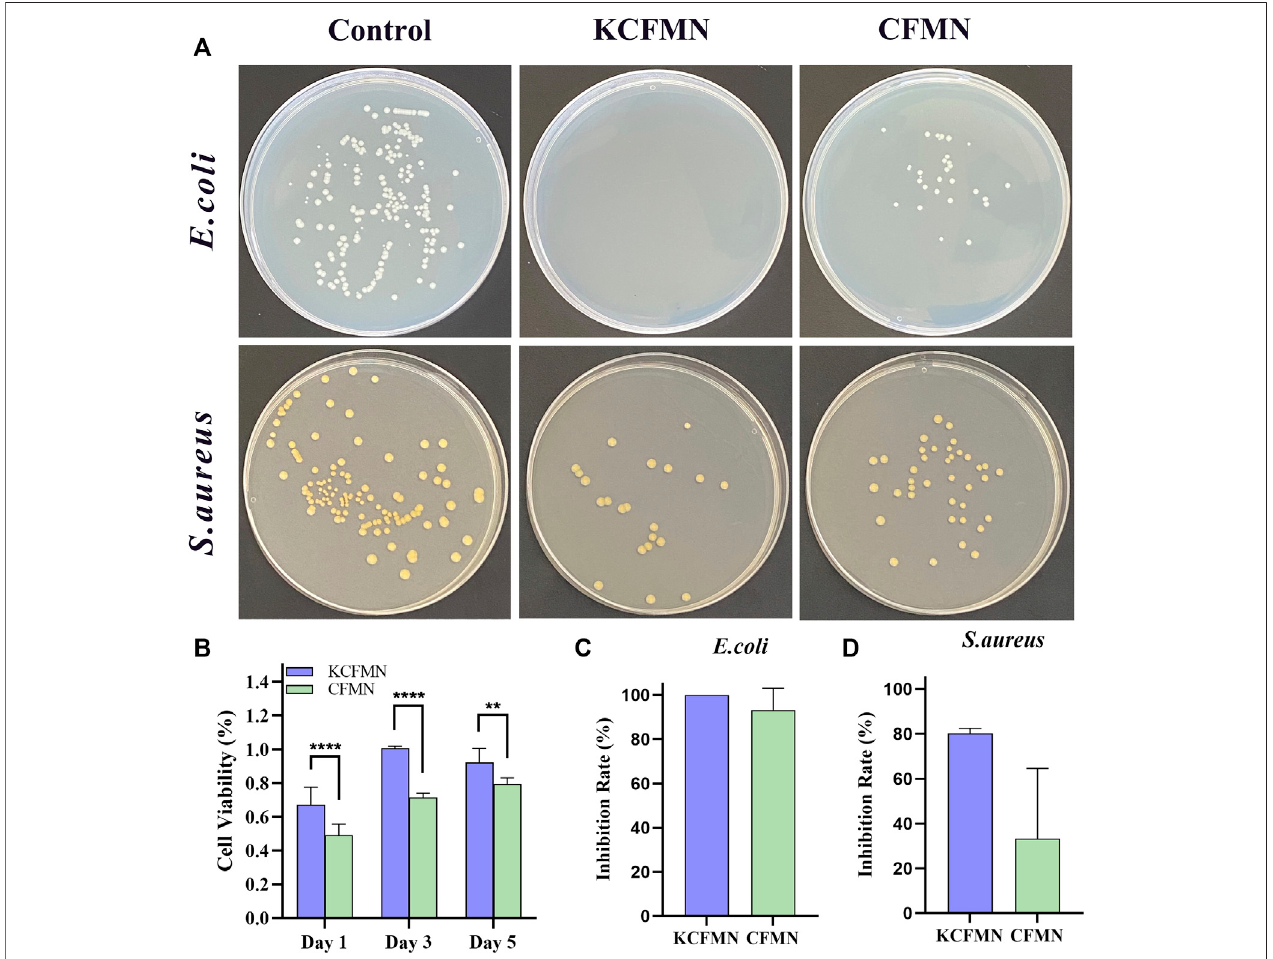
FIGURE4|(A) Photographsofclones onagarplates afterco-culturedwithcontrol,KCFMN,andCFMN. (B) CytocompatibilityanalysisoftheKCFMNand CFMN. The cell viability of MNs on day 1, 3, 5 (** p < 0.01 and **** p < 0.0001). (C) Inhibition rate of E. coli co-cultured with KCFMN and CFMN, respectively. (D) Inhibition rate of S. aureus co-cultured with KCFMN and CFMN,